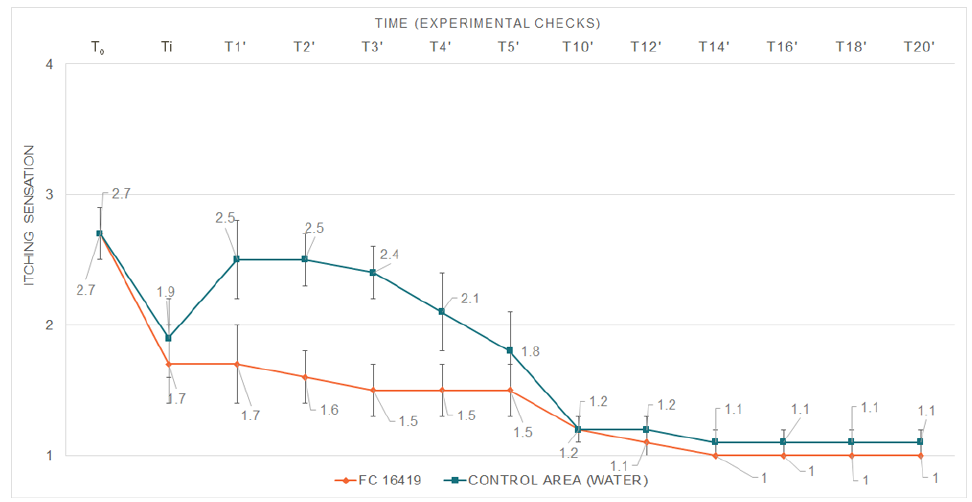
Figure 2. Clinical scoring of itching sensation at different timepoints (Data are reported as mean ± SEM).